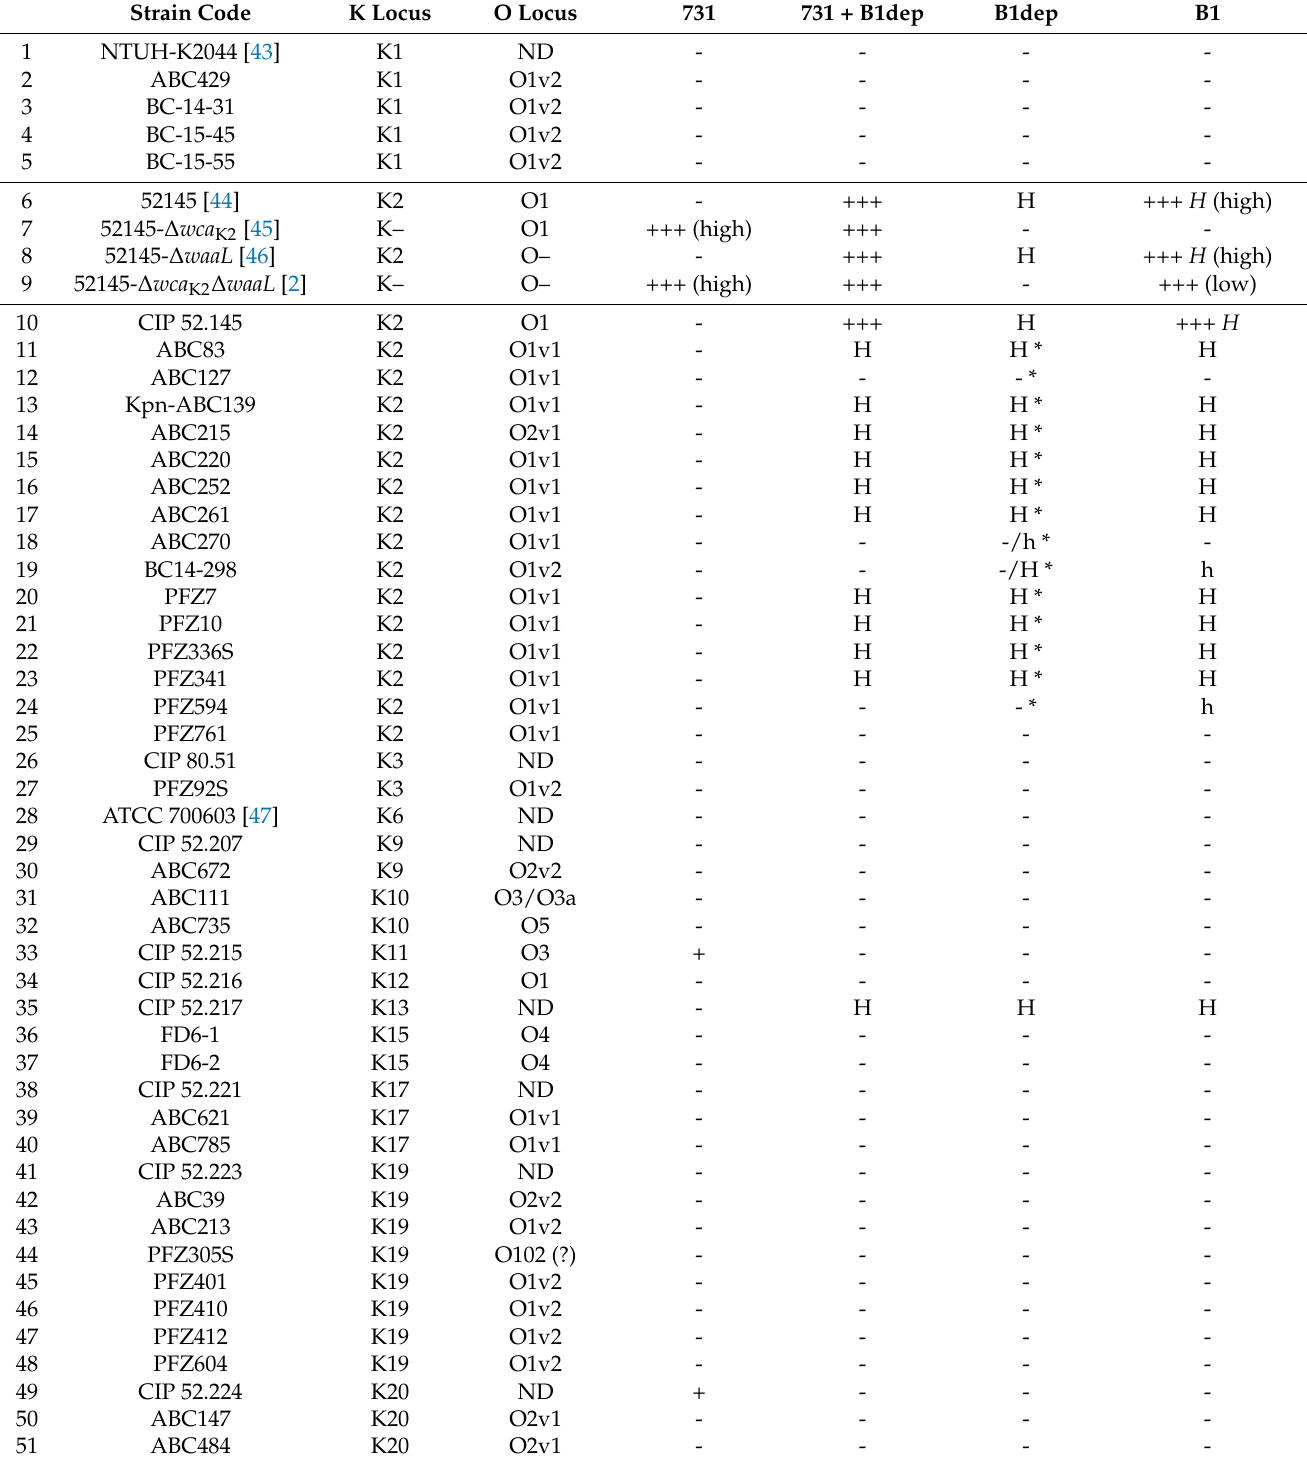
Table 1. Bacterial strains used in this study and host range of phages 731, B1, and B1dep protein. Results were obtained by spot testing and are the mean of three different experiments. +++: clear lysis; +: veiled lysis; -: no effect; H : turbid ring around lysis (halo); H: turbid spot without lysis; h: less translucent turbid spot without lysis, smaller in diameter; *: B1dep was additionally tested on the grown (1-day old) lawn of the given strain; ND: no data available; question mark means uncertainty in the determined serotype. EOP classes are indicated where they were determined as ‘high’ (EOP ≥ 0.5) or ‘low’ (0.001 < EOP <